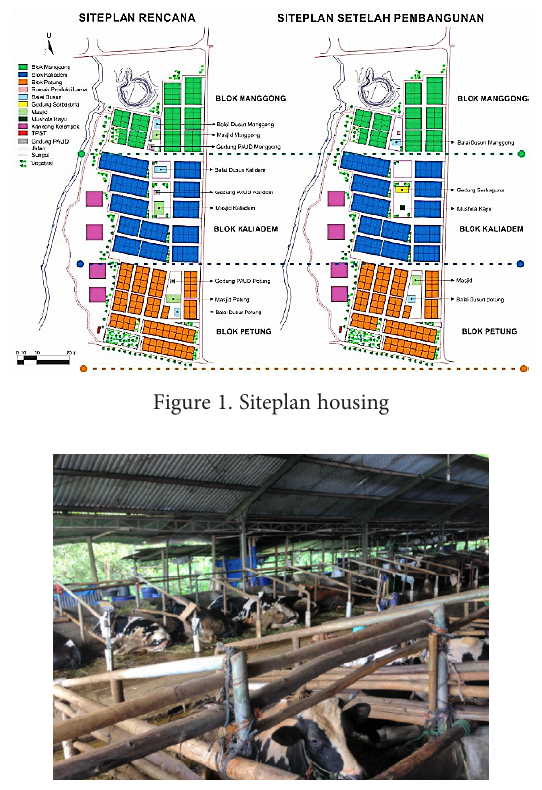
Figure 2. Cattle cage